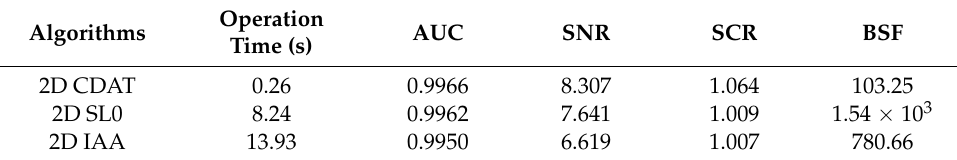
Table 3. Comparison of the algorithm performance of different